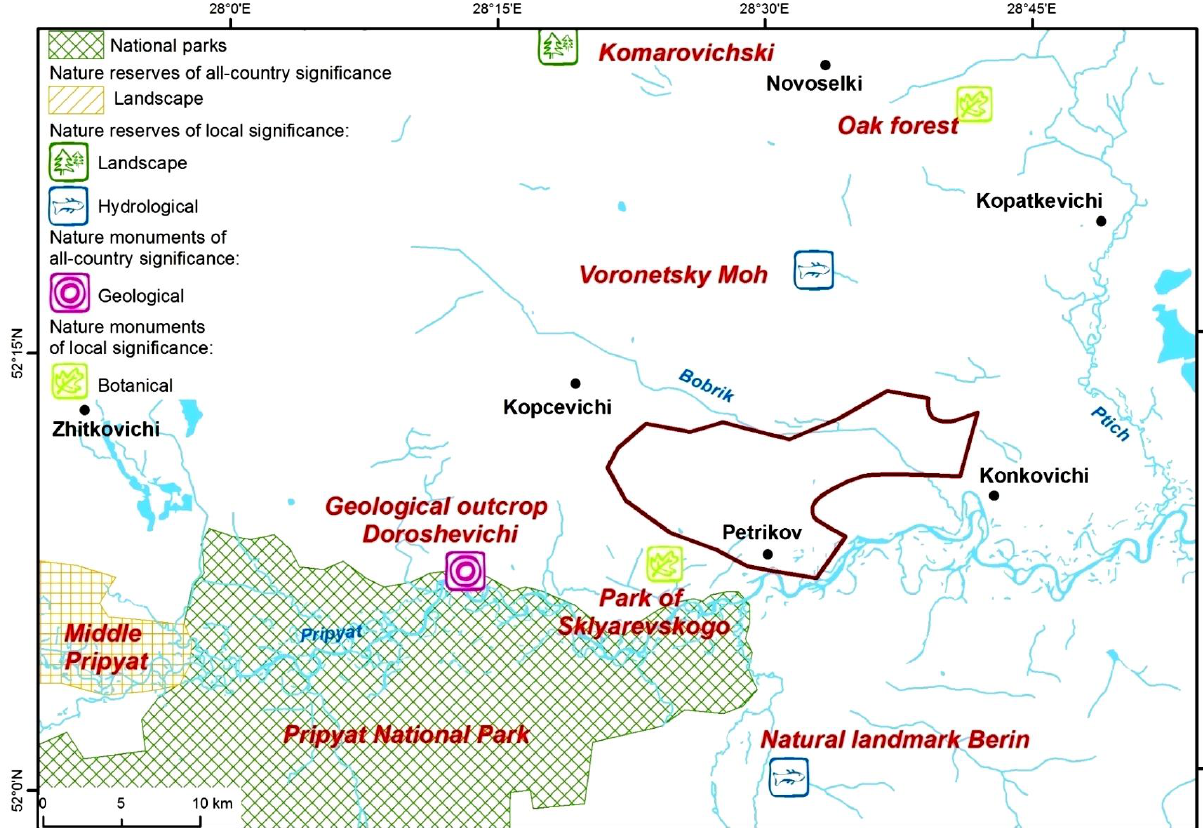
Fig. 3. Nature reserves and monuments within Petrikov potash